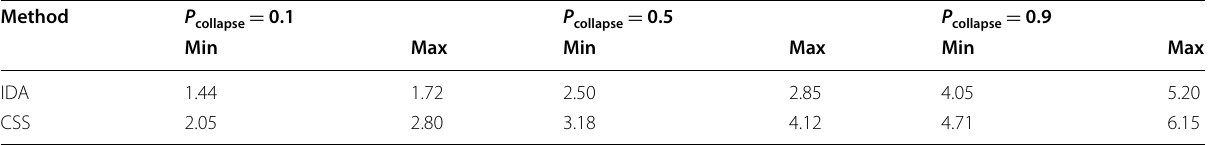
Table 4 Variation in intensity measure (g) for different collapse probabilities. Method P collapse =